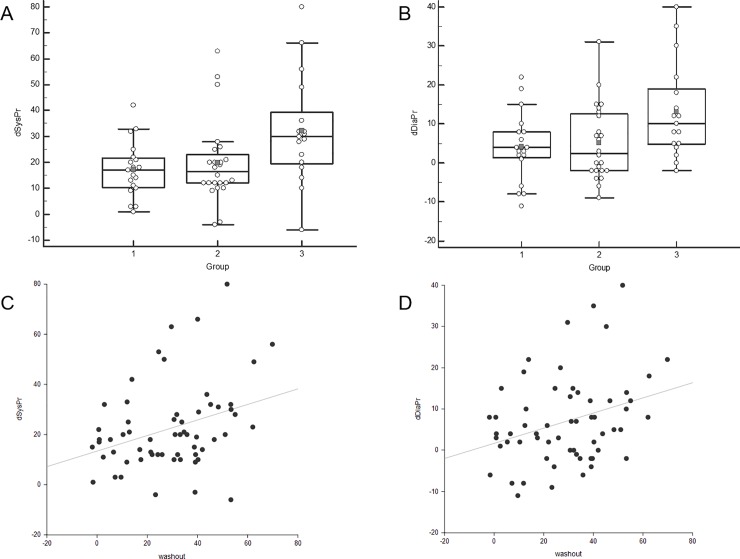
Comparison of the difference of systolic and diastolic pressure.A significant difference is shown in the difference of systolic pressure (A) and the difference of diastolic pressure (B) amongst the three groups. These two parameters also weakly correlated with the WR in all subjects (C, D).